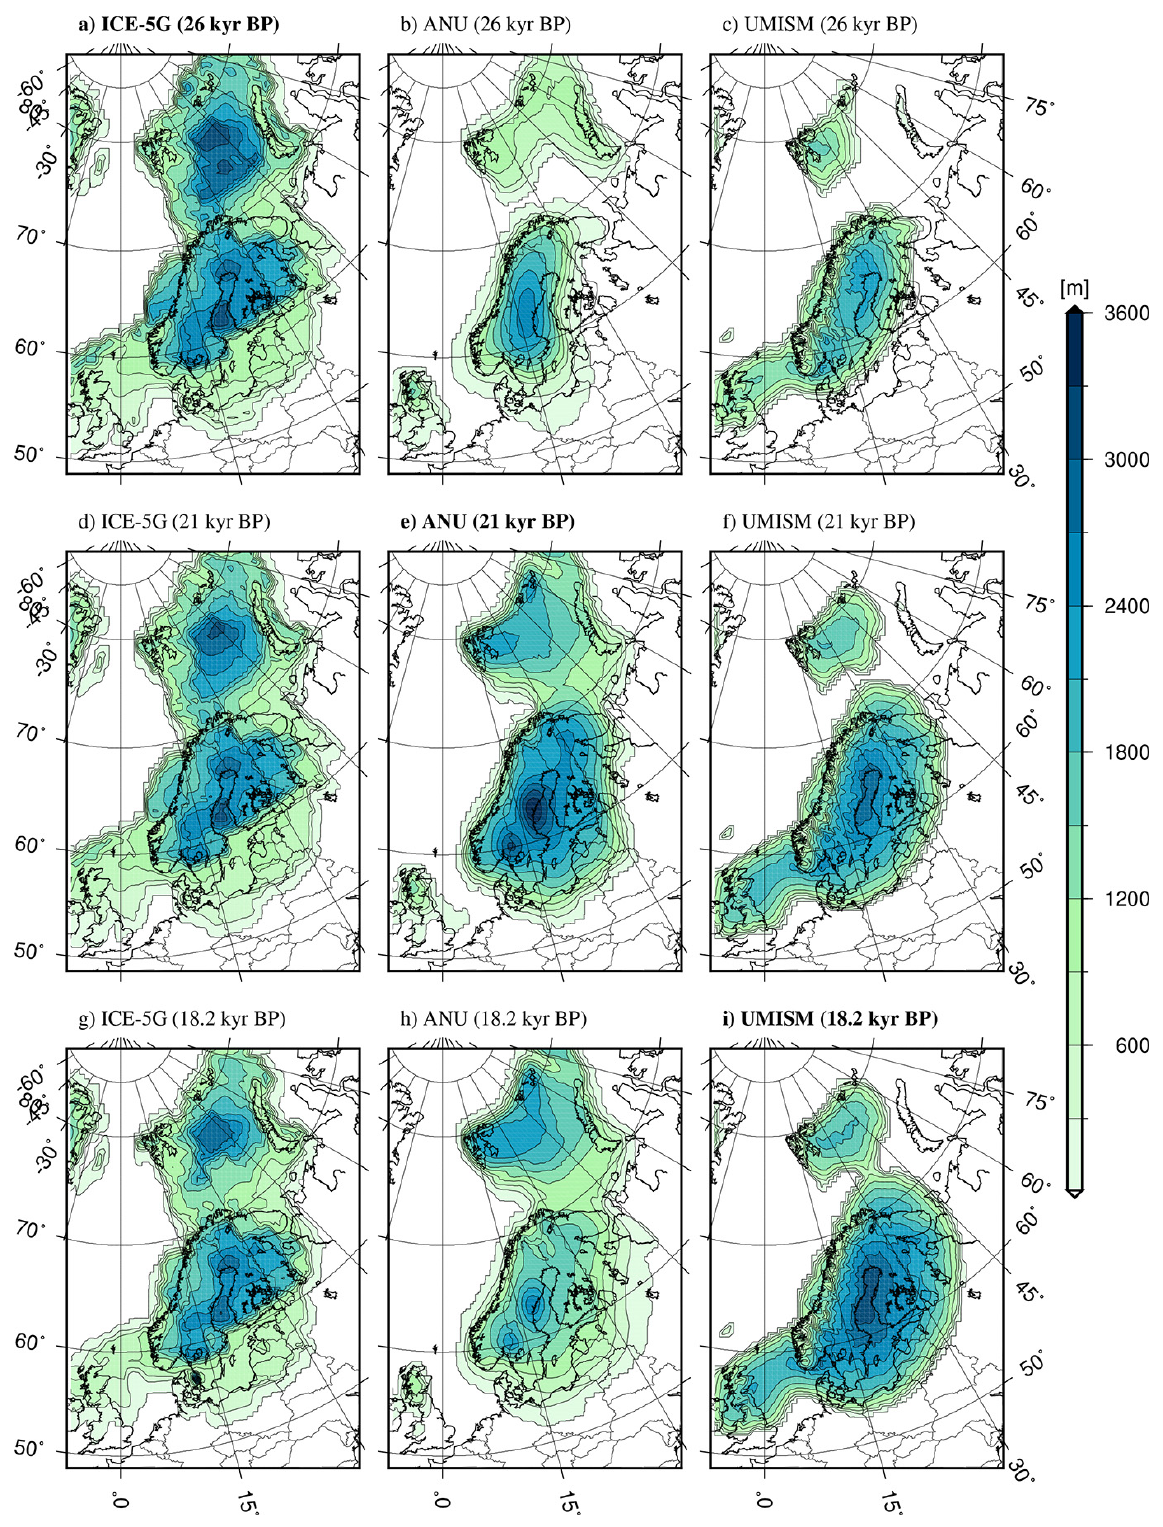
Figure 3. Ice sheet extent and thickness at 26kyrBP ( a–c , LGM of ICE-5G), 21kyrBP ( d–f , LGM of ANU) and 18200BP ( g–i , LGM of UMISM) for ICE-5G ( a , d and g ), ANU ( b , e and h ) and the UMISM model ( c , f and i ). Bold font header indicates the LGM of respective ice sheet reconstruction ( a , e and i ). ICE-5G and ANU ice thicknesses at 18.2kyrBP have been linearly interpolated from adjacent time frames (16.5 and 20kyrBP for ANU, 18 and 19kyrBP for ICE-5G), while the extents have been inherited from the closest preceding snapshot. Solid Earth, 5, 371–388, 2014